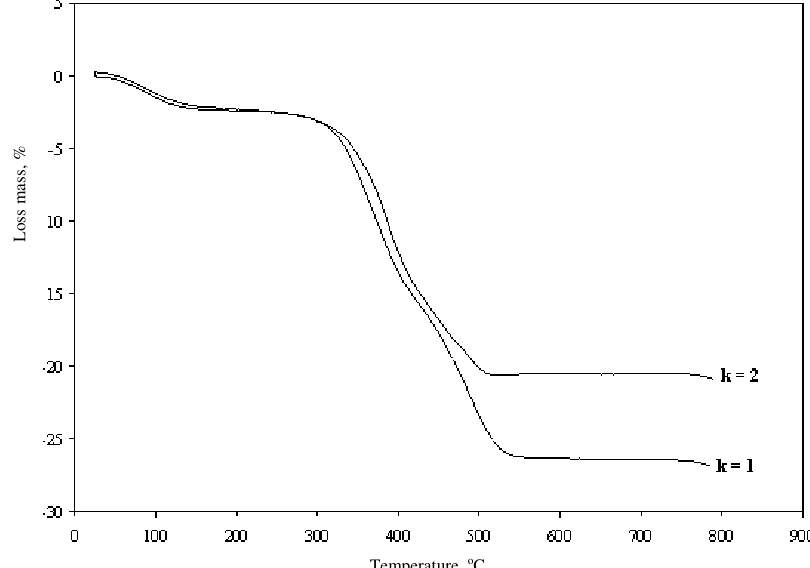
Figure 5. TG curves of the synthesized sample under air atmosphere with different value of k